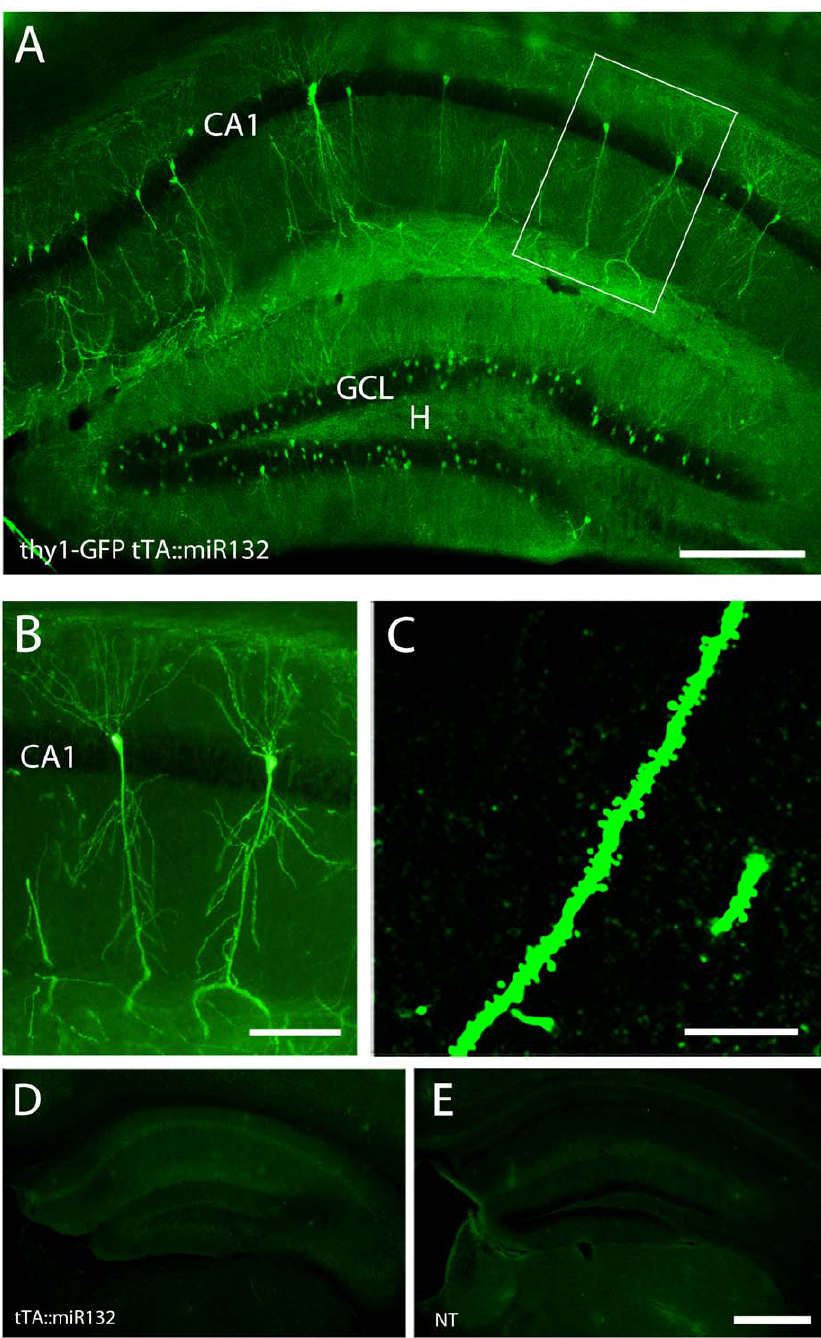
Figure 2. Hippocampal expression of Thy1-GFP. (A) Representative GFP fluorescent immunolabeling of the dorsal hippocampus. A limited subset of CA1 pyramidal neurons and granule cells express the GFP transgene. GCL, granule cell layer; CA1, hippocampal subfield; H, hilus. Framed CA1 pyramidal cell is shown at higher magnification (B), as well as a confocal image of a CA1 dendrite (C). (D) Immunolabeling for TRE-regulated CFP expression in a tTA::miR132 transgenic mouse. At the antibody concentration used to reveal Thy-1 driven GFP expression (presented in A ), minimal expression of CFP was detected. (E) As a further control, wild type (WT) tissue was immunolabeled using the GFP antibody: minimal non-specific labeling was detected. Of note, all images presented here (except for the confocal image in C) used identical data collection and analysis settings. Scale bars: 200 m m in A, 100 m m in B, 10 m m in C, 200 m m in D.